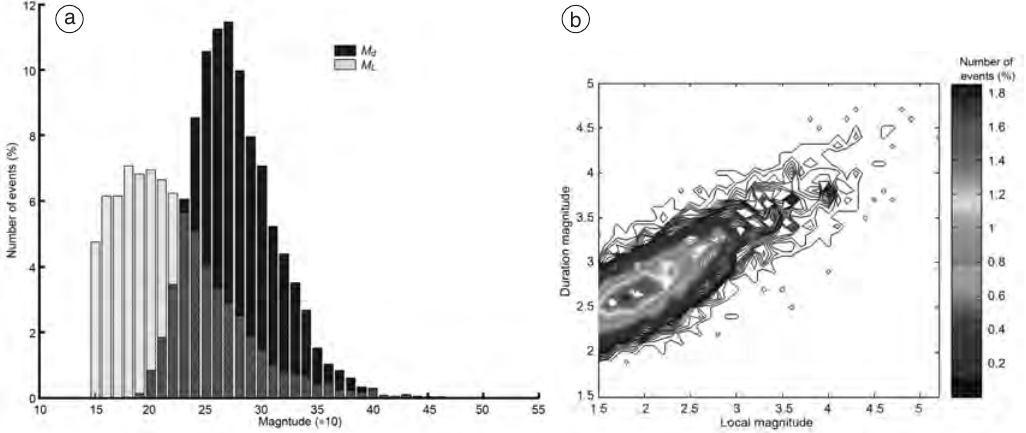
Fig. 5a,b. a) Discrepancy between the frequency of the events for class of magnitude M d and M L . b) Three-di- mensional vision of the correspondences between M d and M L